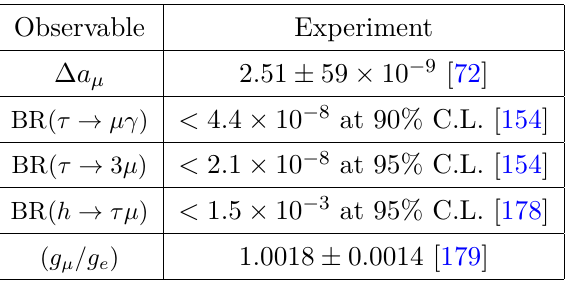
Table 4 . World average measurement of ∆ a µ and experimental bounds for the LFV decay and LFU observables considered in our